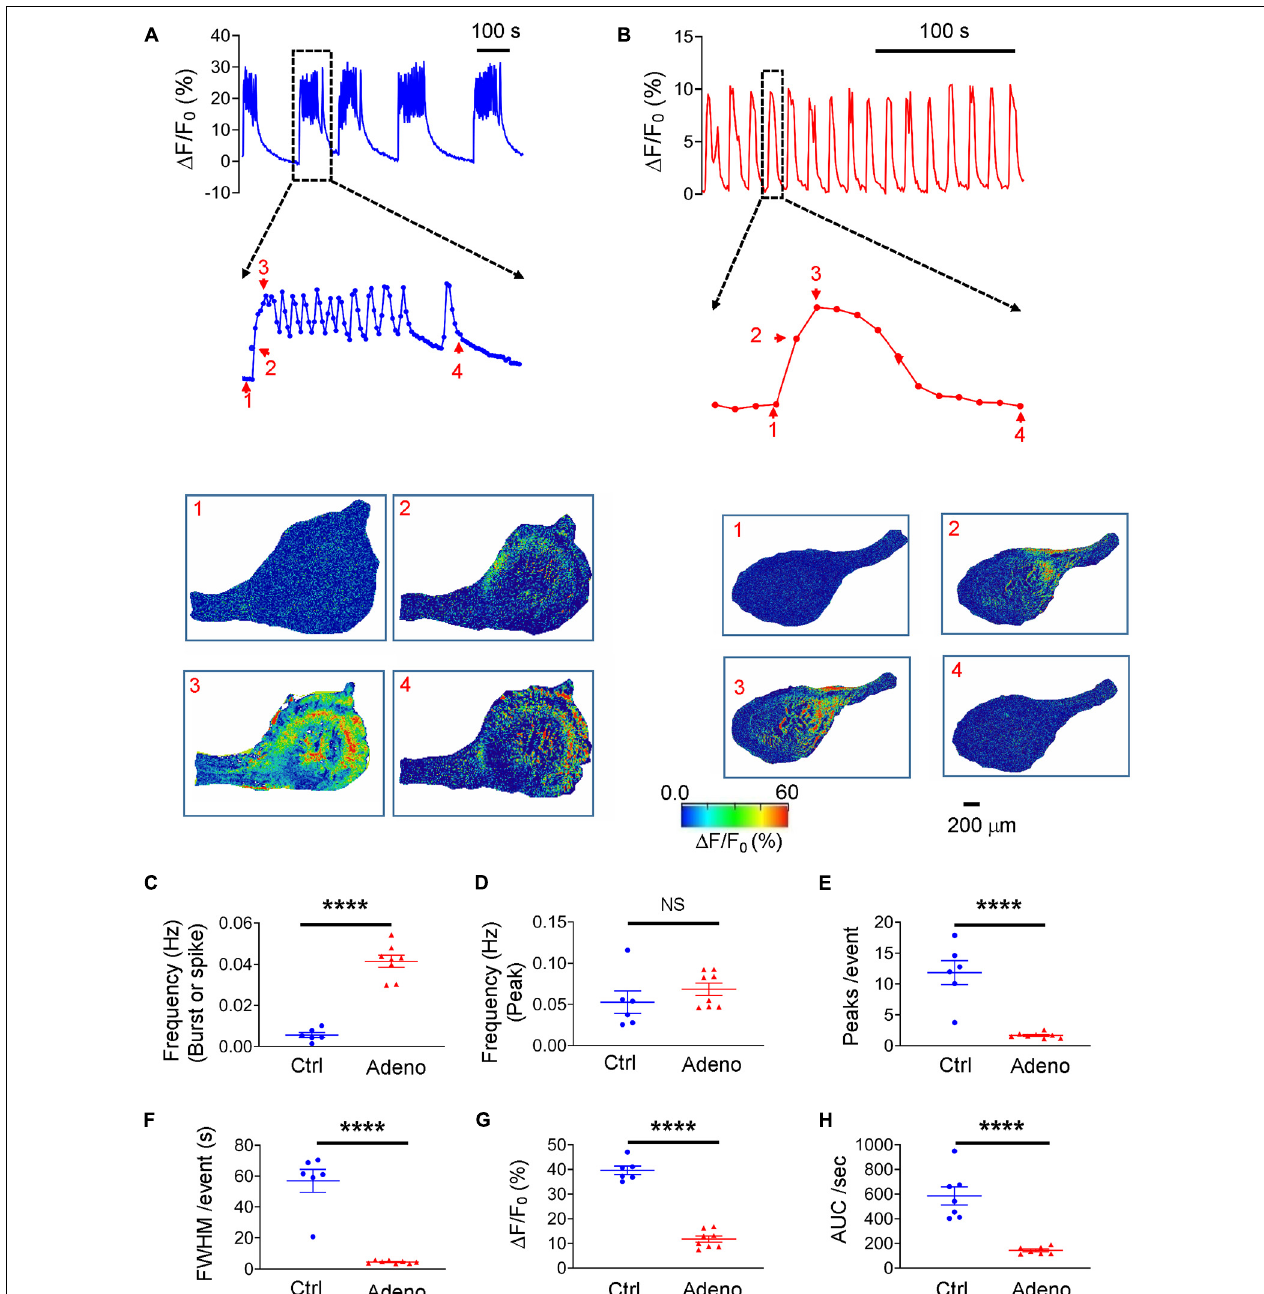
FIGURE 8 | Changes in spontaneous Ca 2 + oscillations in neonatal adenomyotic mice. (A) Typical Ca 2 + oscillations in uterine slices from postnatal day (PND) 14 mice after treatment with the vehicle for tamoxifen (Ctrl). A burst event marked with the dotted line box is shown in an expanded time scale, and images below the trace are snapshots of this event as indicated by the corresponding numbers near the trace. (B) Typical Ca 2 + oscillations in uterine slices from PND14 mice after treatment with tamoxifen. An event marked with the dotted line box is shown in an expanded time scale, and images below the trace are snapshots of this event, as shown by the corresponding numbers near the trace. (C) Ca 2 + oscillation frequency when a burst or a spike was counted as an event (the same convention is applied to panels E–H ). (D) Ca 2 + oscillation frequency when a peak in bursts or spikes was counted as an event. (E) Numbers of Ca 2 + oscillations per event in Ctrl and Adeno mice at PND14. (F) Full width at half maximum (FWHM)/event in Ctrl and Adeno mice at PND14. (G) Amplitude of Ca 2 + oscillations in Ctrl and Adeno mice at PND14. (H) Calcium intensity (AUC × Frequency) in Ctrl and Adeno mice at PND14. Note that each data point in panels C–H is an average value from multiple slices in a mouse, and each slice was recorded for 30 min. N.S., no statistical significance, **** P < 0.0001 with unpaired Student’s t -test [ N = 6 Ctrl mice (14–17 slices) and 8 Adeno mice (18–23 slices) for panels C–H ].